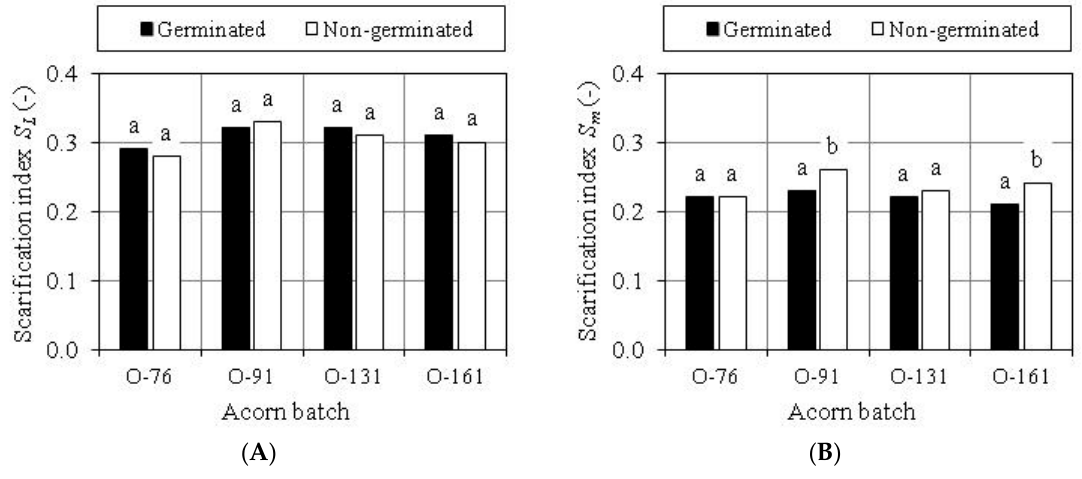
Figure 5. Significance of differences in the dimensional ( A ) and mass ( B ) scarification index of germinated and non-germinated acorns: a, b—different letters denote statistically significant differences.